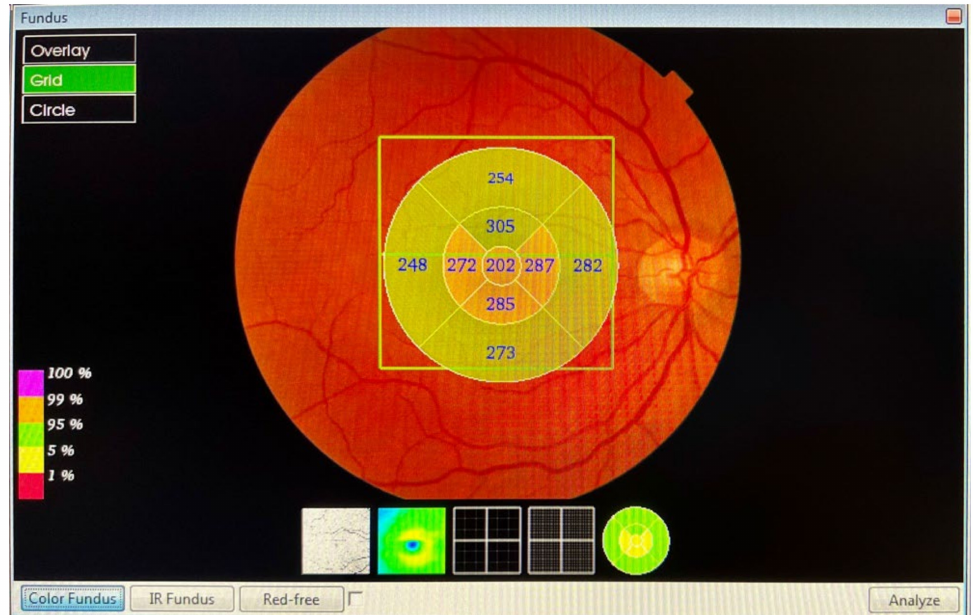
Figure 1. The 3D Macula Report